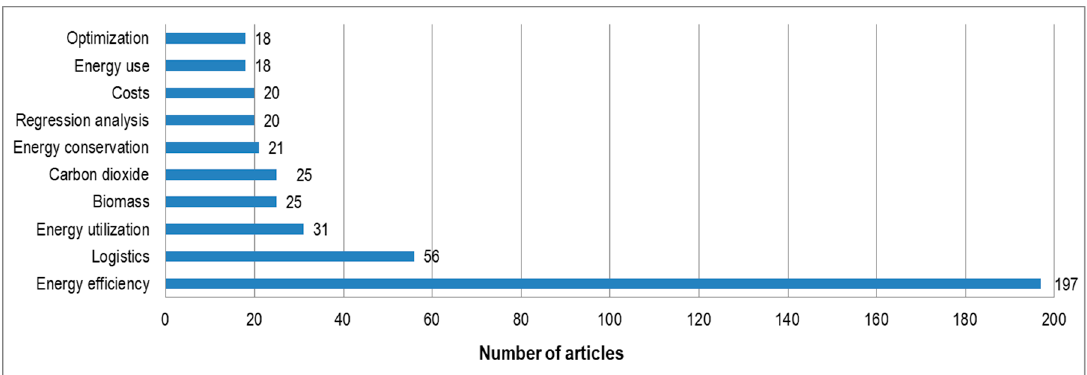
Figure 2. Classification of articles by year of publication.